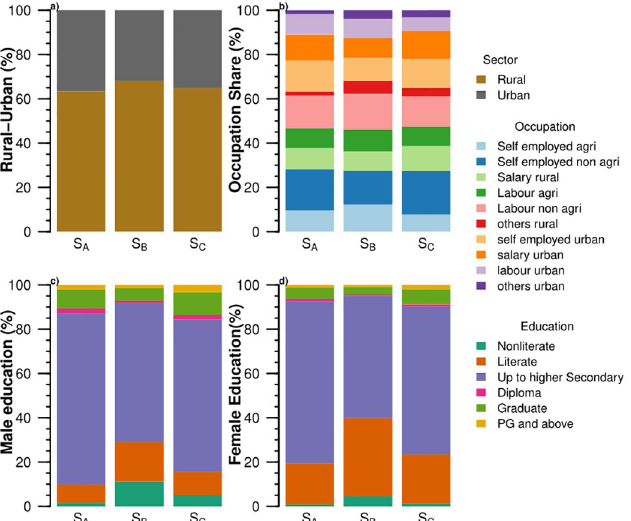
Fig 5. Socioeconomic features of Subsidy-based food systems (S households, (b) the share of occupation classes, (c) the share of the highest education among male members, and (d) the share of the highest education among female